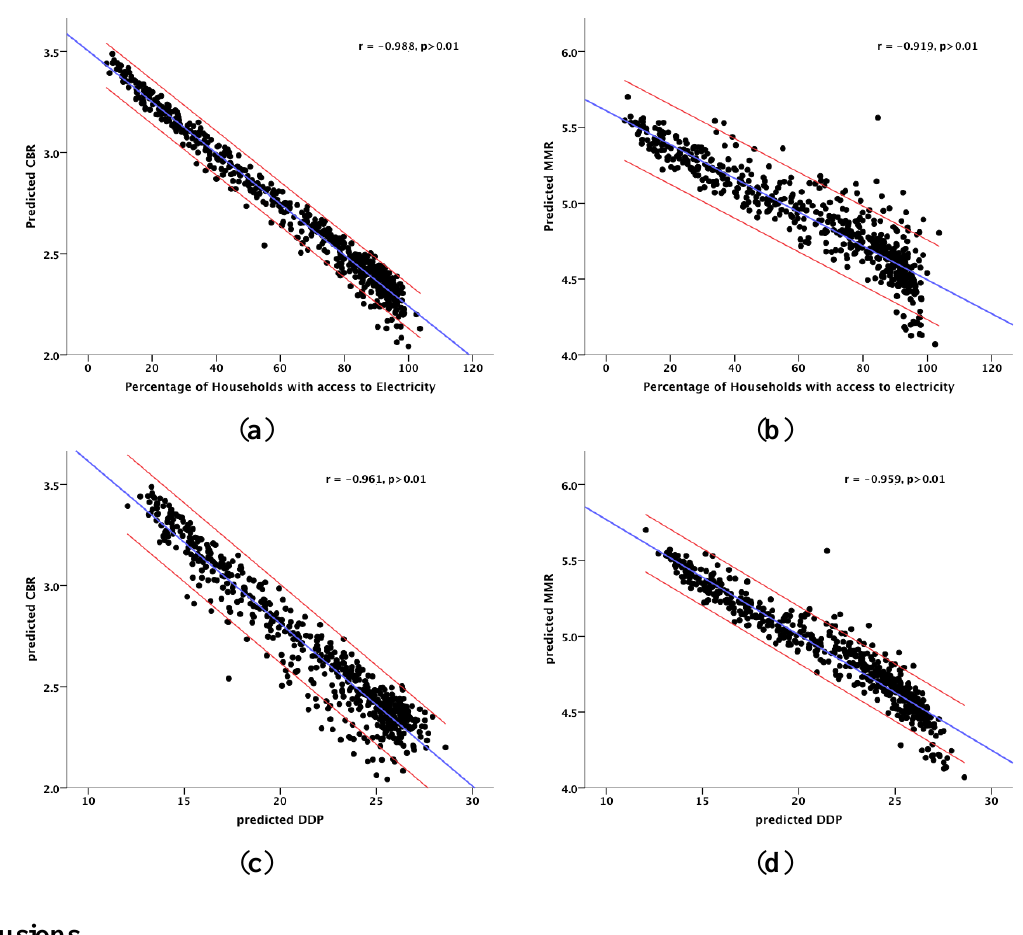
Figure 7. Correlations between health metrics (CBR and MMR) and development indicators (rate of electrification and DDP) for India. ( a ) CBR and electricity; ( b ) MMR and electricity; ( c ) CBR and DDP; ( d ) MMR and